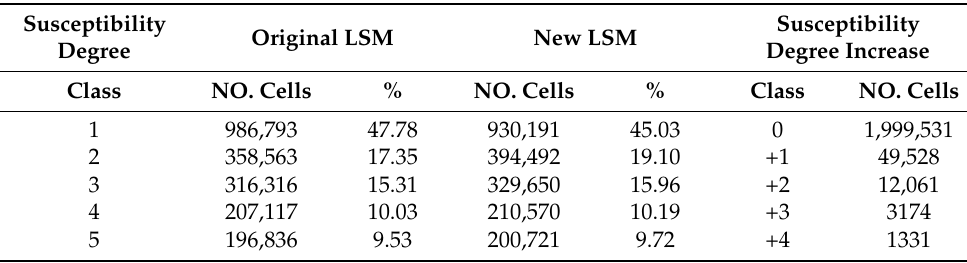
Table 3. Comparison of the original landslide susceptibility assessment degrees with the revised degrees after